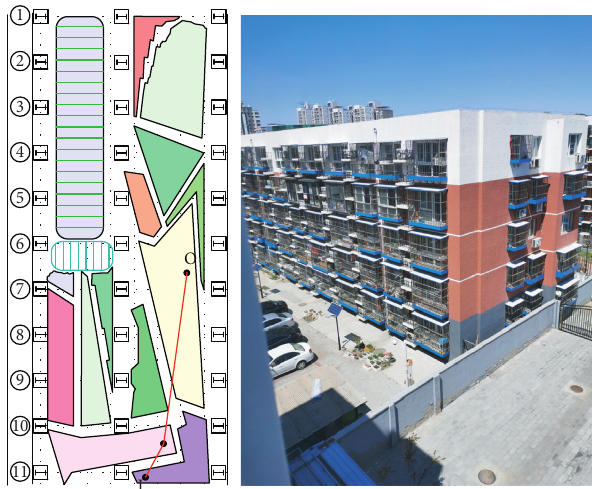
Figure 4: Planning display of civil engineering project from the perspective of O-I.